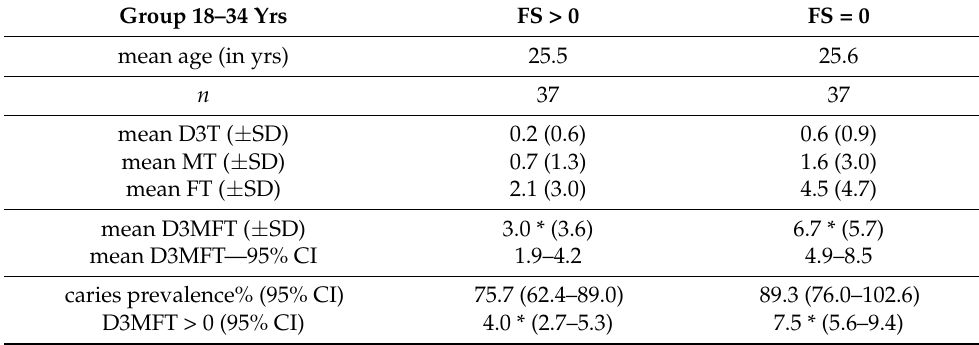
Table 4. Association between fissure sealants and D3MFT-value in 18- to 34- year-old